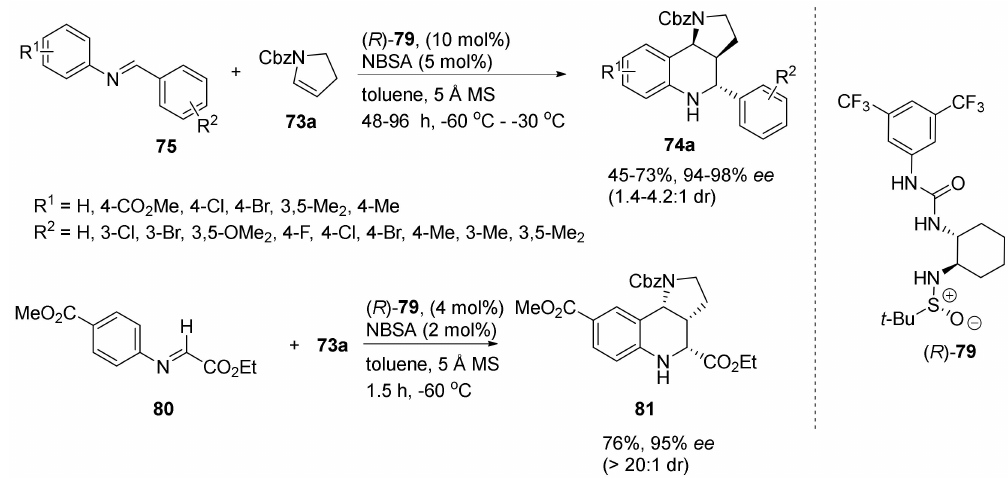
Scheme 12. Organocatalytic scaffold synthesis developed in the Jacobsen group.